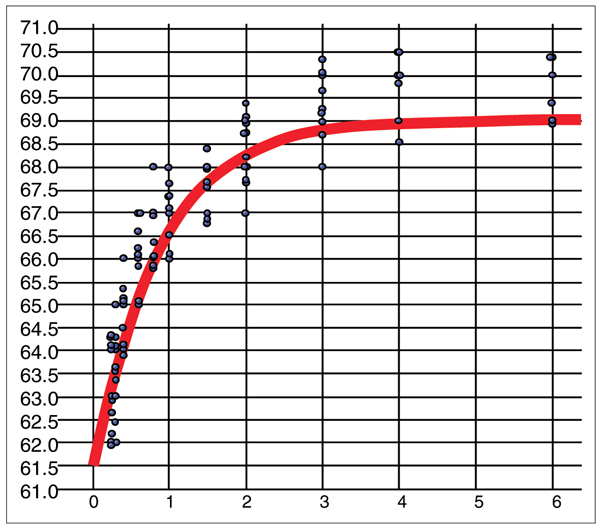
Accuracy as a function of training set size. Percentage of correct exons (F score) is shown on the y-axis and training set size in thousands is shown on the x-axis. Data points (N = 121) are shown in blue; the best fit function of the form y = a/(1+be-cx+d) is shown in red; a = 69.01, b = 0.0152, c = 0.0012, d = 2.09. The curve is effectively flat for values of x above 6,000 (not shown). The curve for nucleotide and gene level accuracies and for the second test set are of very similar shape. F = 2 × Sn × Sp/(Sn + Sp).